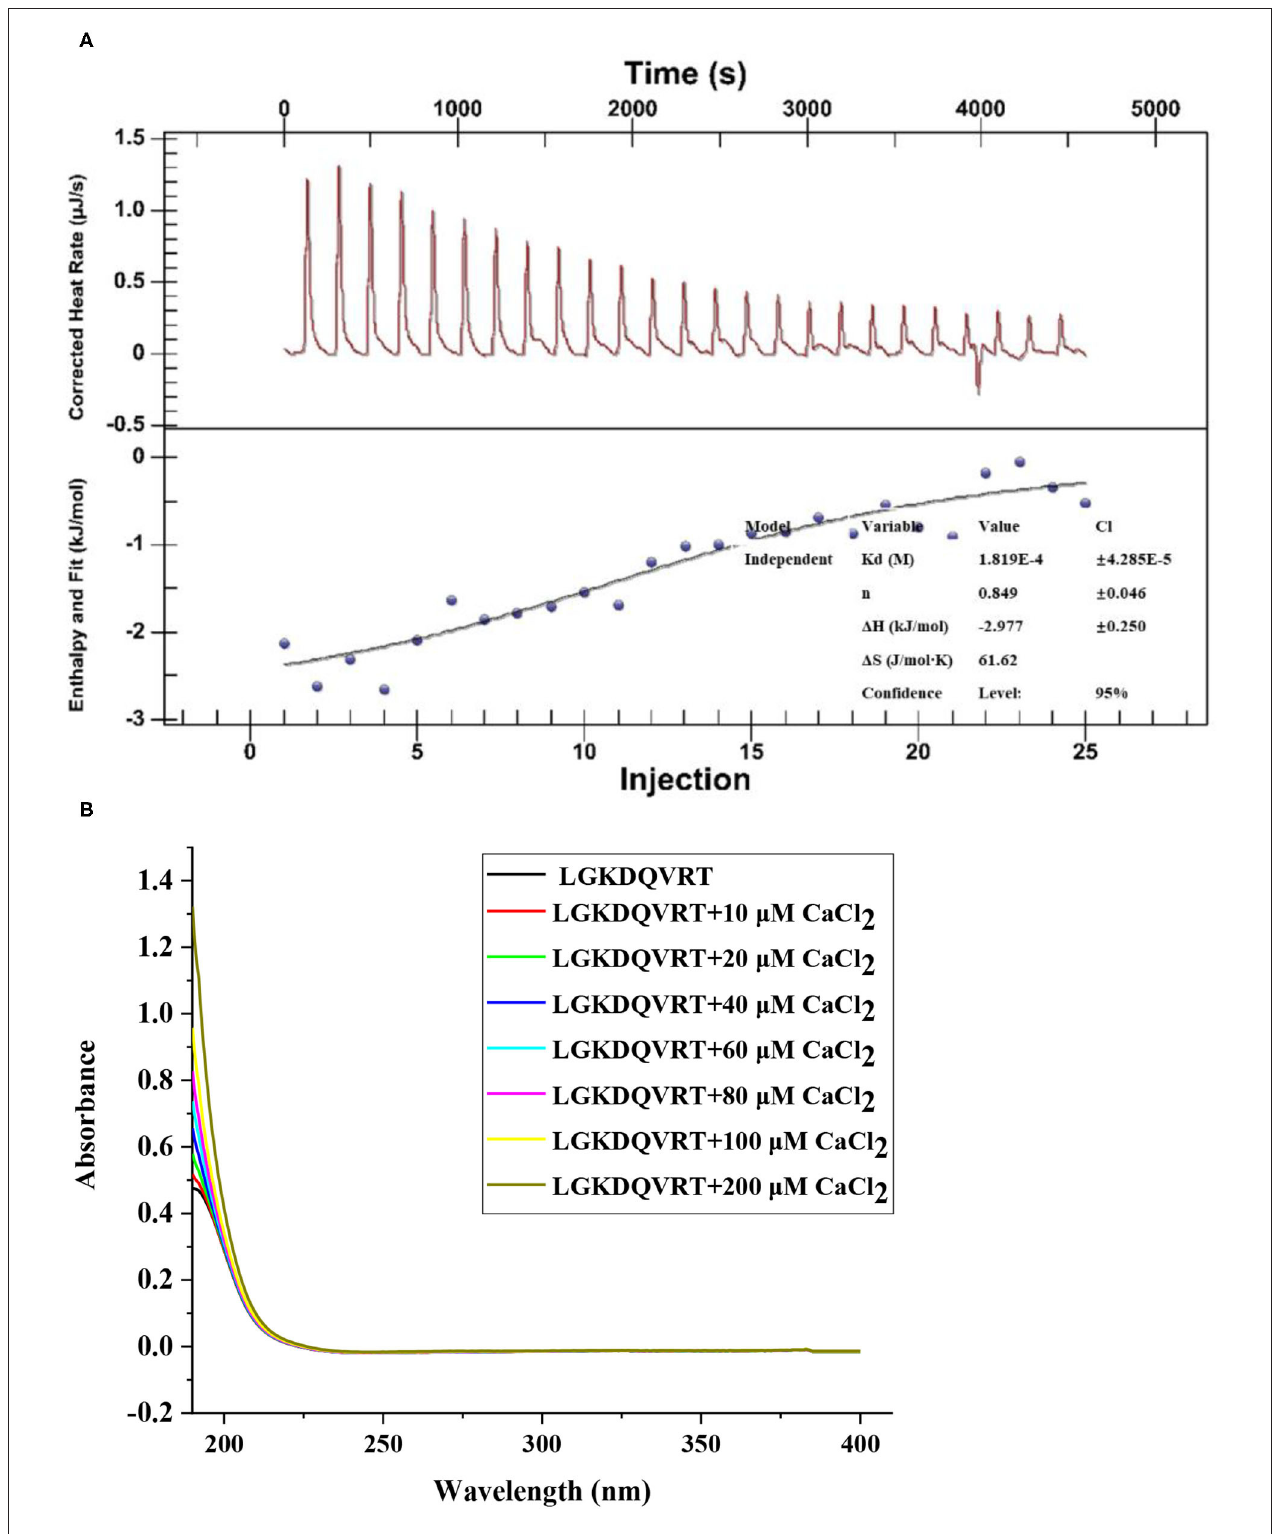
FIGURE 1 | (A) The raw ITC data obtained from continuous injection of 2.0 µ L CaCl 2 solution to LGKDQVRT solution. Titration plot derived from the integrated heats of binding of the raw ITC data. (B) UV spectra of LGKDQVRT with different CaCl 2 concentrations over the wavelength range from 190 to 400 nm.